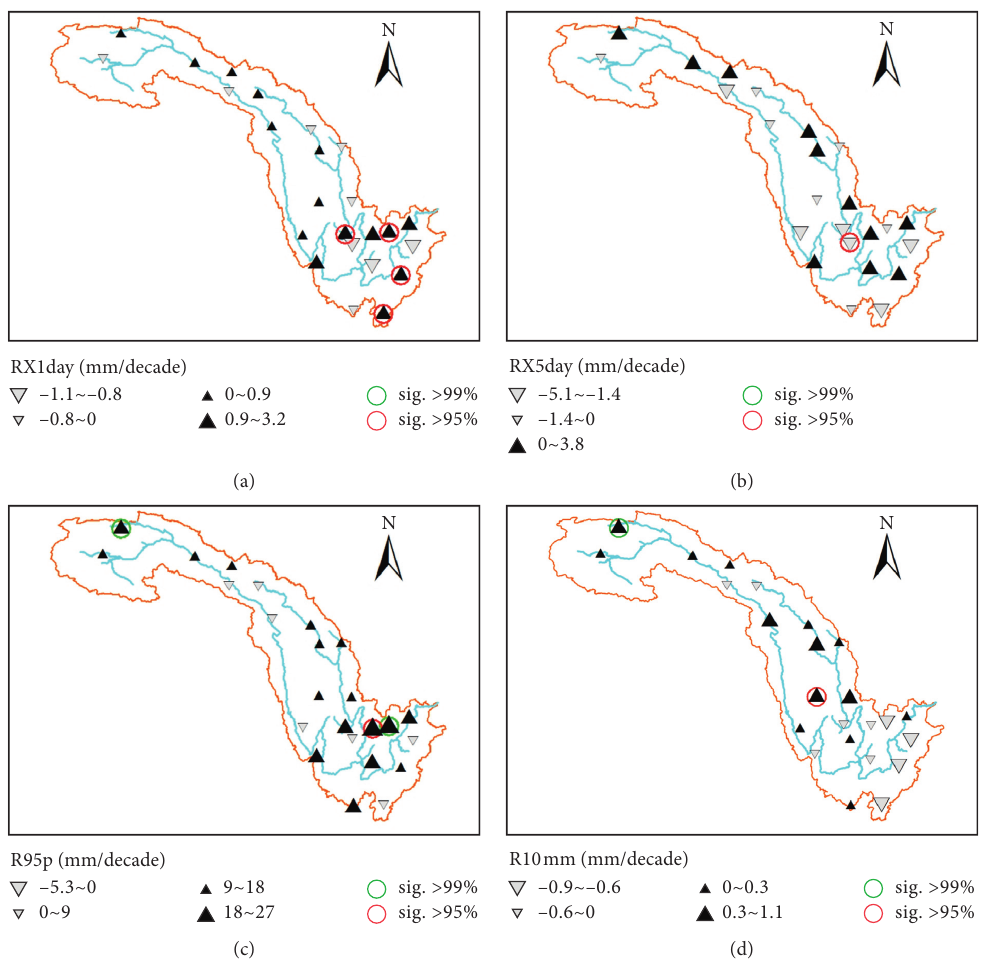
Figure 5: Spatial distributions of decadal trends of extreme precipitation indices in the JRB. Black triangles denote increasing trends; grey triangles denote decreasing trends. Red and green circles represent significance of